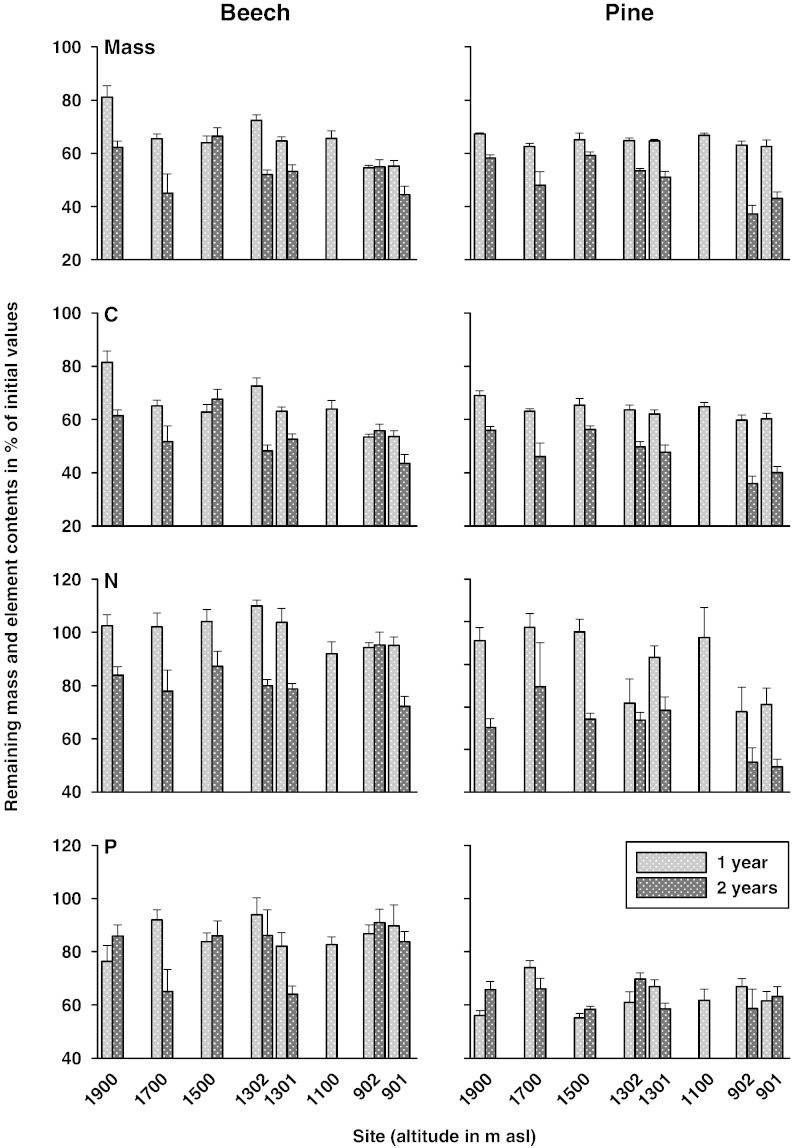
Remaining mass and contents of C, N and P (percent of initial values) of exposed beech and pine litter at the eight study sites along an elevation gradient after 1 and 2 years. Data are given as means with standard error (N = 5).